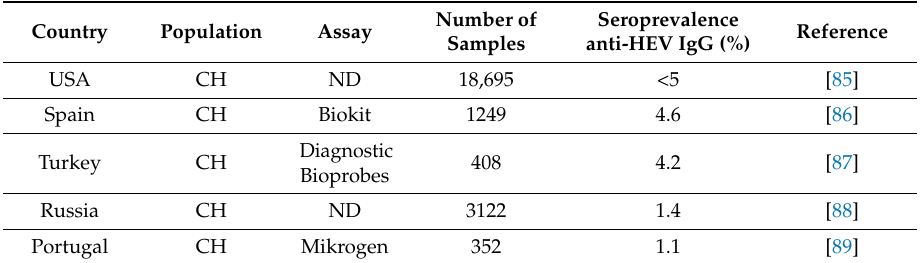
Table 4. HEV IgG prevalence observed in children.